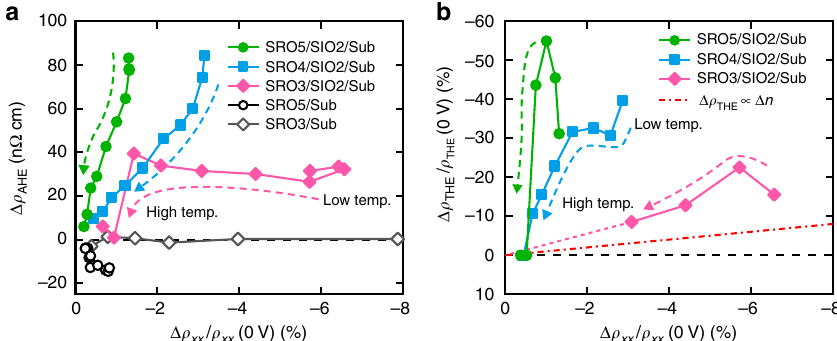
Fig. 4 Qualitative analyses of modulations in AHE and THE. a Difference in anomalous Hall resistivity ( Δ ρ AHE ) between V G = 200 V and V G = − 180 V as a function of longitudinal resistivity variation ratio ( Δ ρ xx / ρ xx (0 V)) at temperatures ranging from 2 K to 80 K. b Modulation ratio of topological Hall resistivity ( Δ ρ THE / ρ THE (0 V)) as a function of Δ ρ xx / ρ xx (0 V). Red dash-dotted line is the calculated variation where gate bias only changes carrier density ( Δ n ). Pink dotted line is the guide to the eyes. Broken arrows indicate temperature